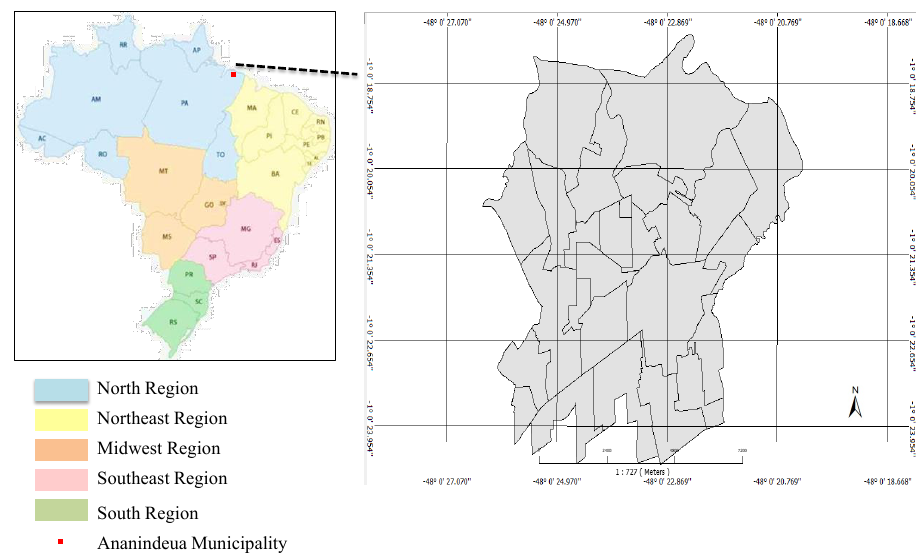
Figure 1. Municipality of Anandindeua/Par á -2022. Source: TerraView/IEC/UEPA, 2022.